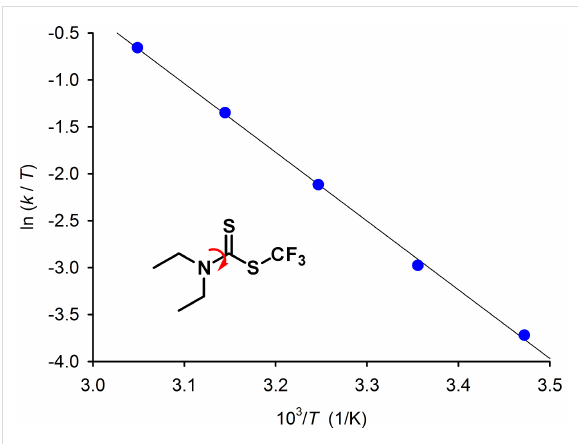
Figure 2: The Eyring plot obtained for the rotation around the N–C bond in compound 4c .